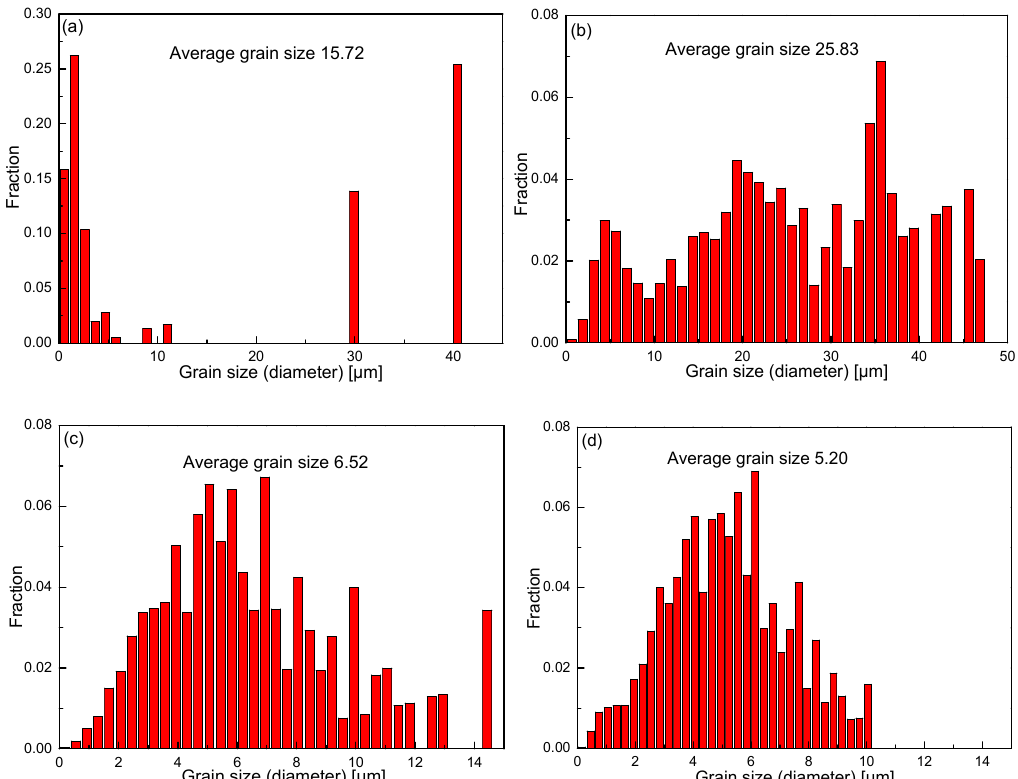
Figure 5. The average grain size of MDFed alloy after different passes: ( a ) 1 pass, ( b ) 2 passes, ( c ) 3 passes, ( d ) 4 passes.